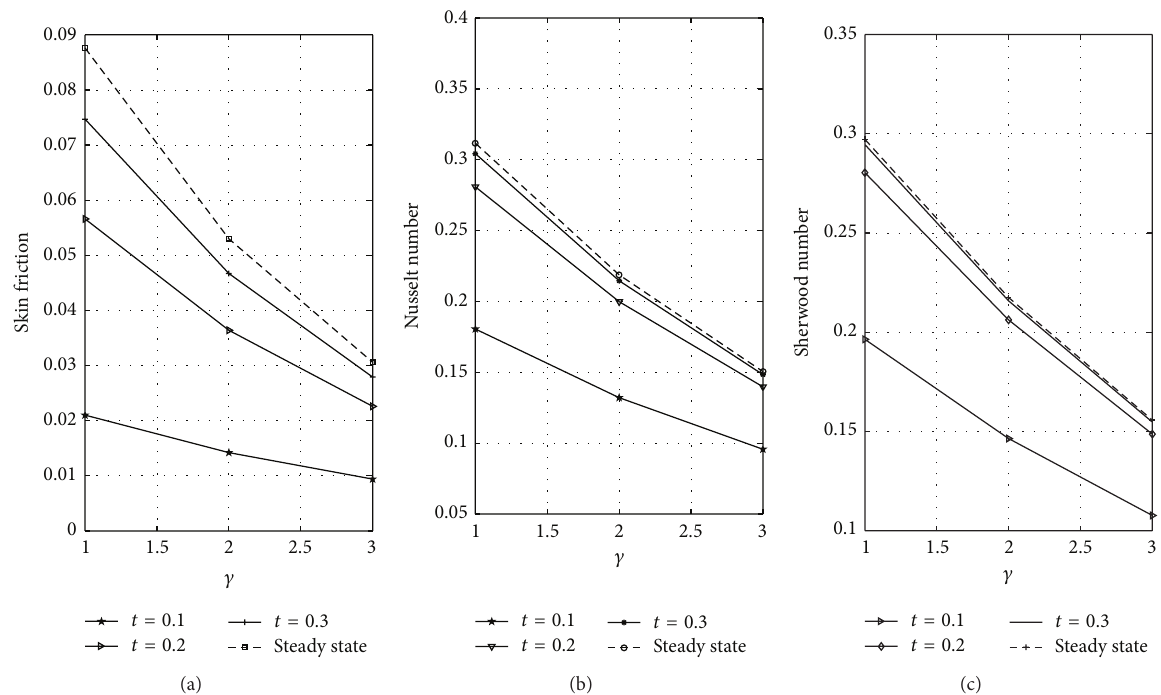
Figure 15: Variation of skin friction, Nusselt number, and Sherwood number with 𝛾 and time ( 𝑡 ) at 𝑦 = 1 .